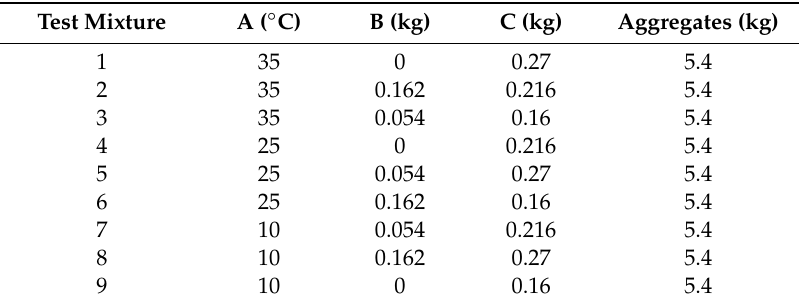
Table 8. The mass of each material.